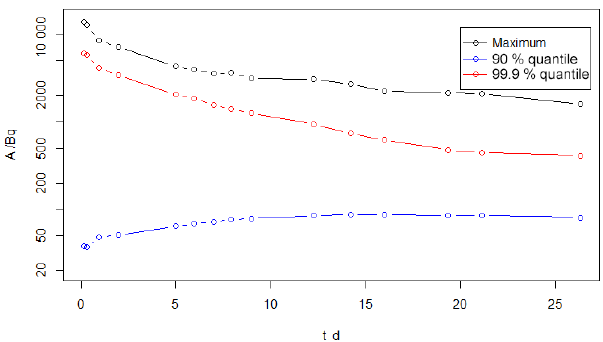
Figure 10. Maximum, 99.9, and 90% quantiles of the amplitude of Fig. 9 vs. frame time of Fig. 9. The colour scale in Fig. 9 refers to the maximum value.